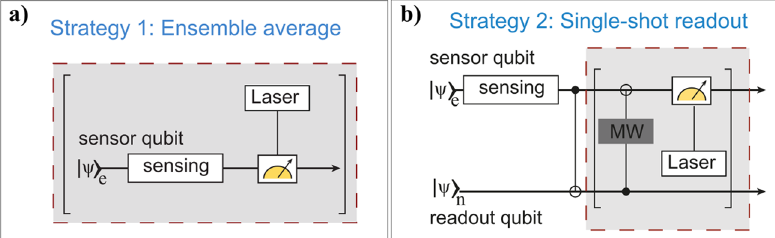
Fig. 4 Experimental realization of the two readout strategies — ensemble averaging and SSR. a Ensemble averaging. The complete sequence of sensor initialization, sensing period, and optical readout is performed N ens times. b Single-shot readout (SSR). After one sensing duration, the sensor state is mapped onto the ancilla readout qubit ( 13 C nucleus). Optical readout of the ancilla spin is weakly perturbing, allowing its population to be probed N RR times with a quantum non-demolition